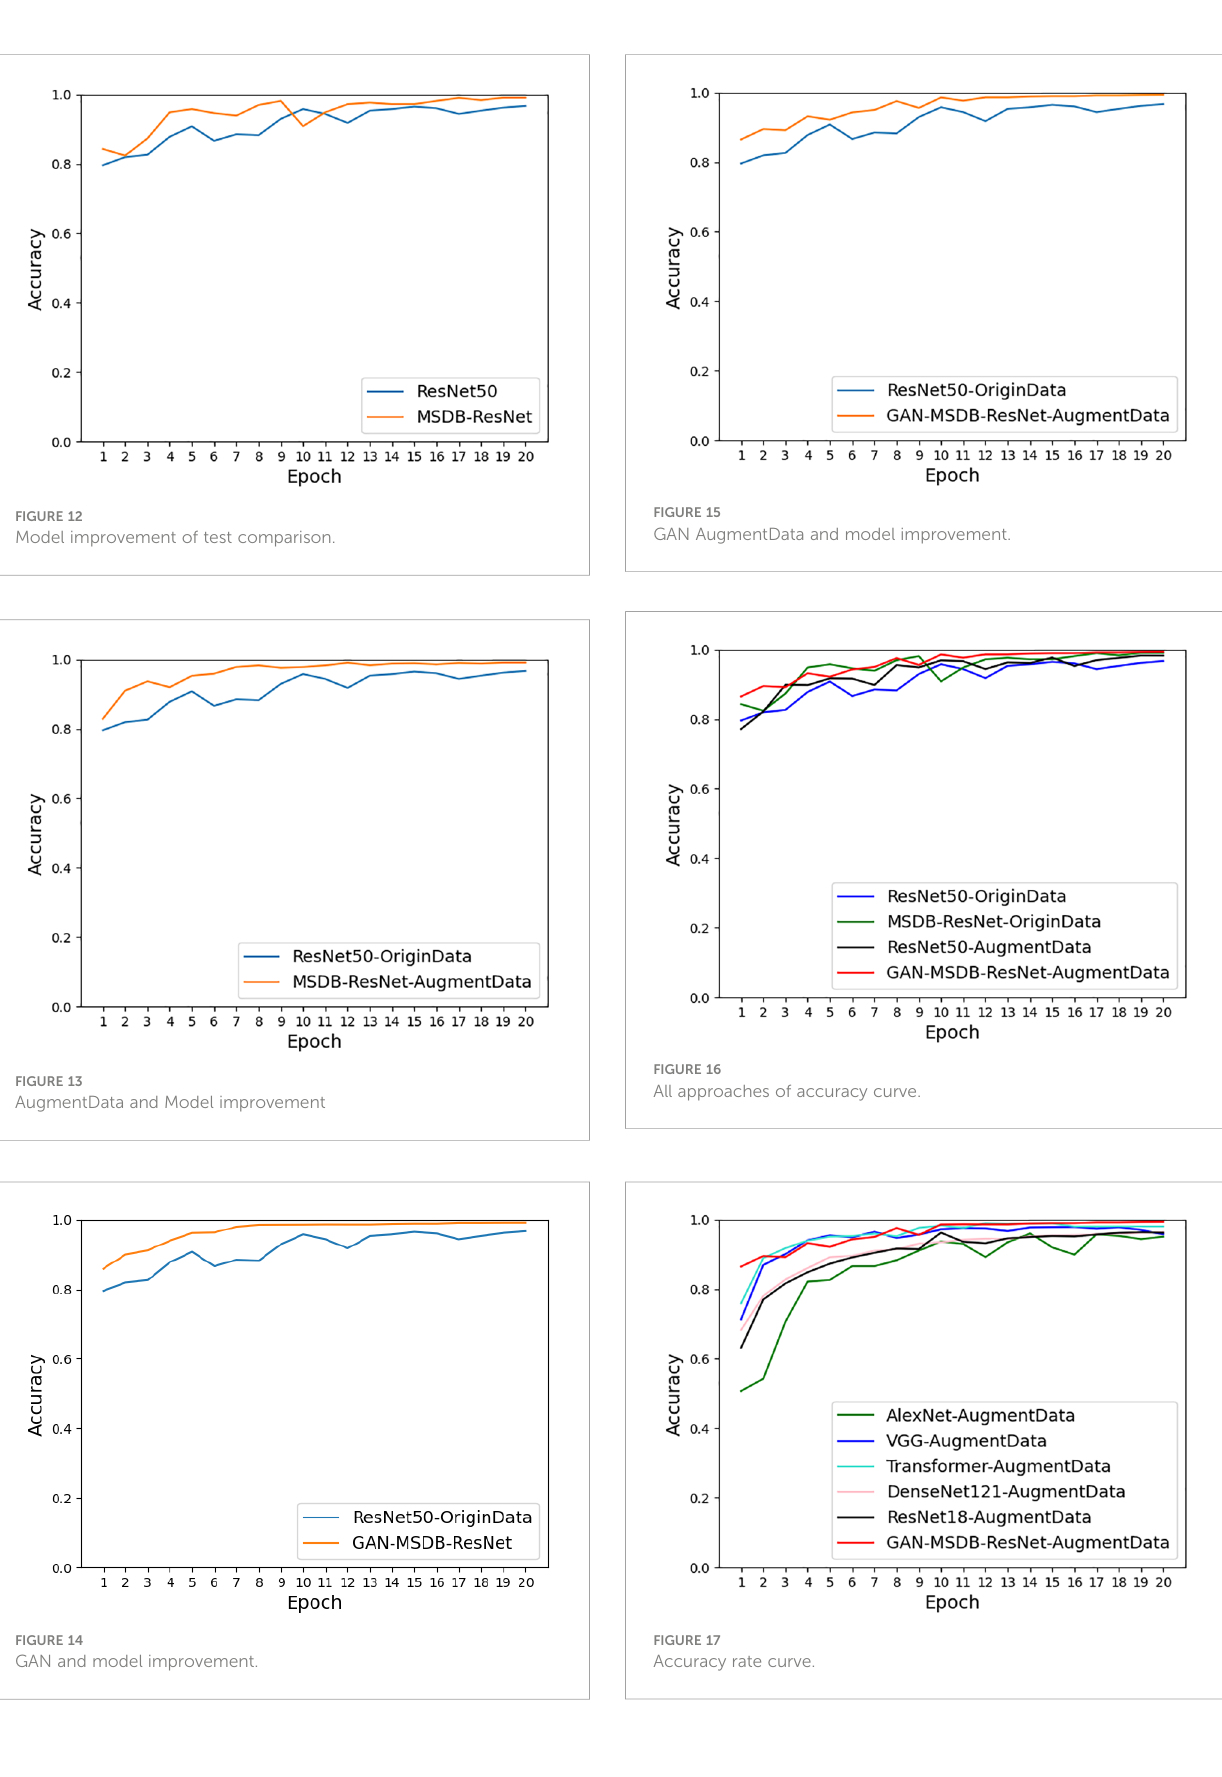
FIGURE 14 GAN and model improvement.